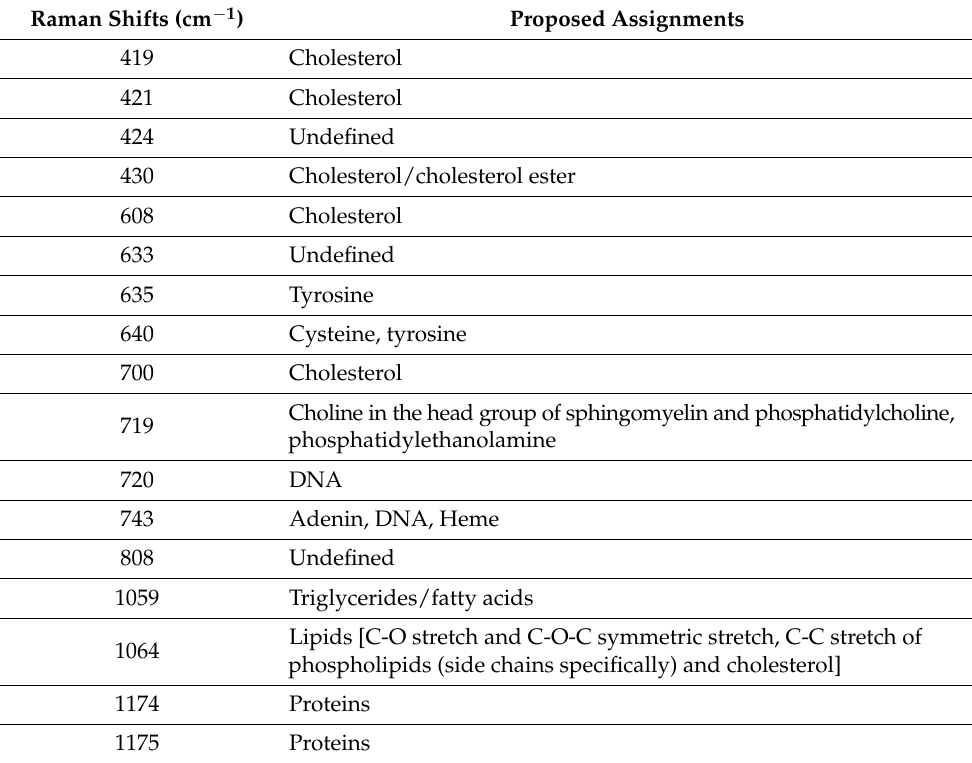
Table 2. Proposed assignment of the main Raman shifts based on pre-existing bibliography